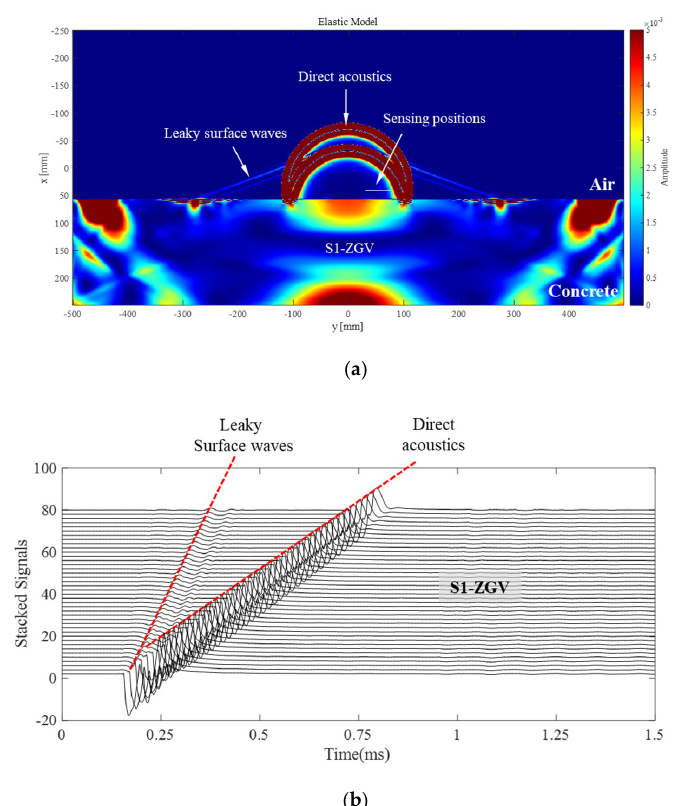
Figure 1. Illustration of air-coupled impact-echo (IE) test; ( a ) Field image of simulation, ( b ) synthetic signal data of simulation.